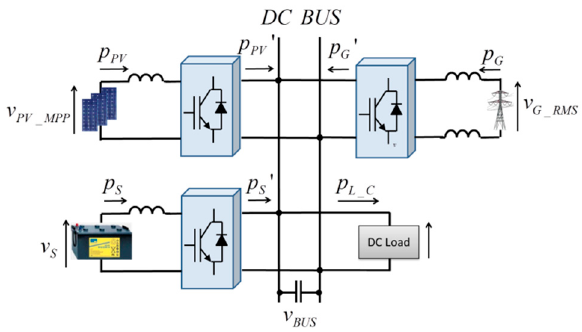
Figure 1. DC microgrid architecture.